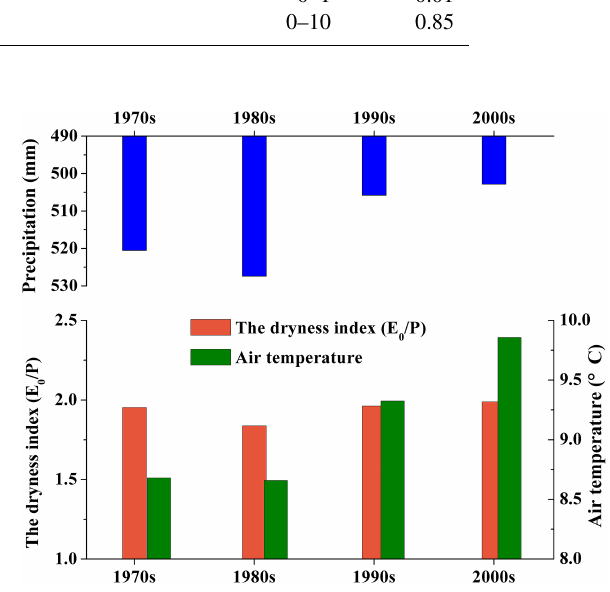
Figure 2. Variation in decadal mean precipitation (top), dryness in- dex, and air temperature (bottom) in the Jinghe River basin from the 1970s to the 2000s. The dryness index was defined as the ratio of annual potential evapotranspiration ( E 0 ) to annual precipitation ( P